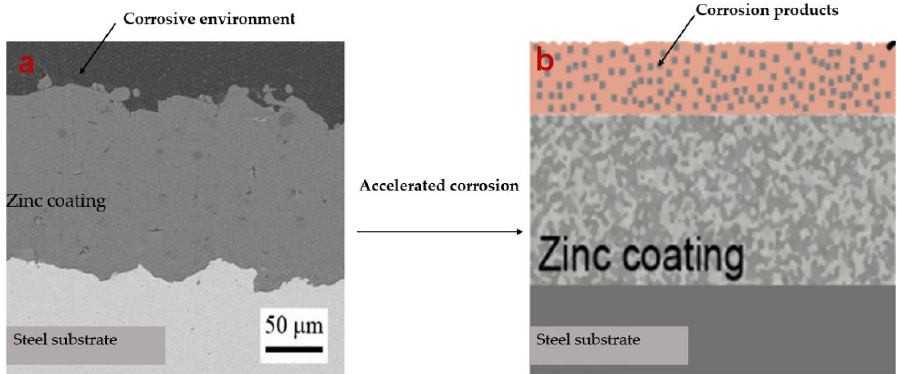
Figure 16. Schematic representation of the basis for obtaining the coating life equation. ( a ) The cross- section of the zinc coating; ( b ) Cross-sectional view of corrosion products formed by zinc coating .